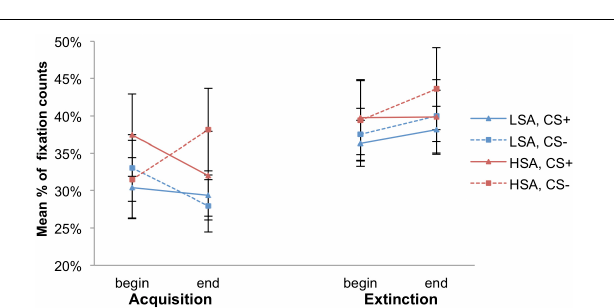
FIGURE 6 | Mean count of fixations within the social area of interest (face and body) as well as environment for low (LSA) and high socially anxious (HSA) participants ( n = 53). CS+ = agent paired with aversive unconditioned stimulus (US); CS − = agent without aversive US; NS = agent without aversive US and appearing only in the extinction phase; Acq = acquisition phase; Ext = extinction phase. Standard errors are presented by error bars.